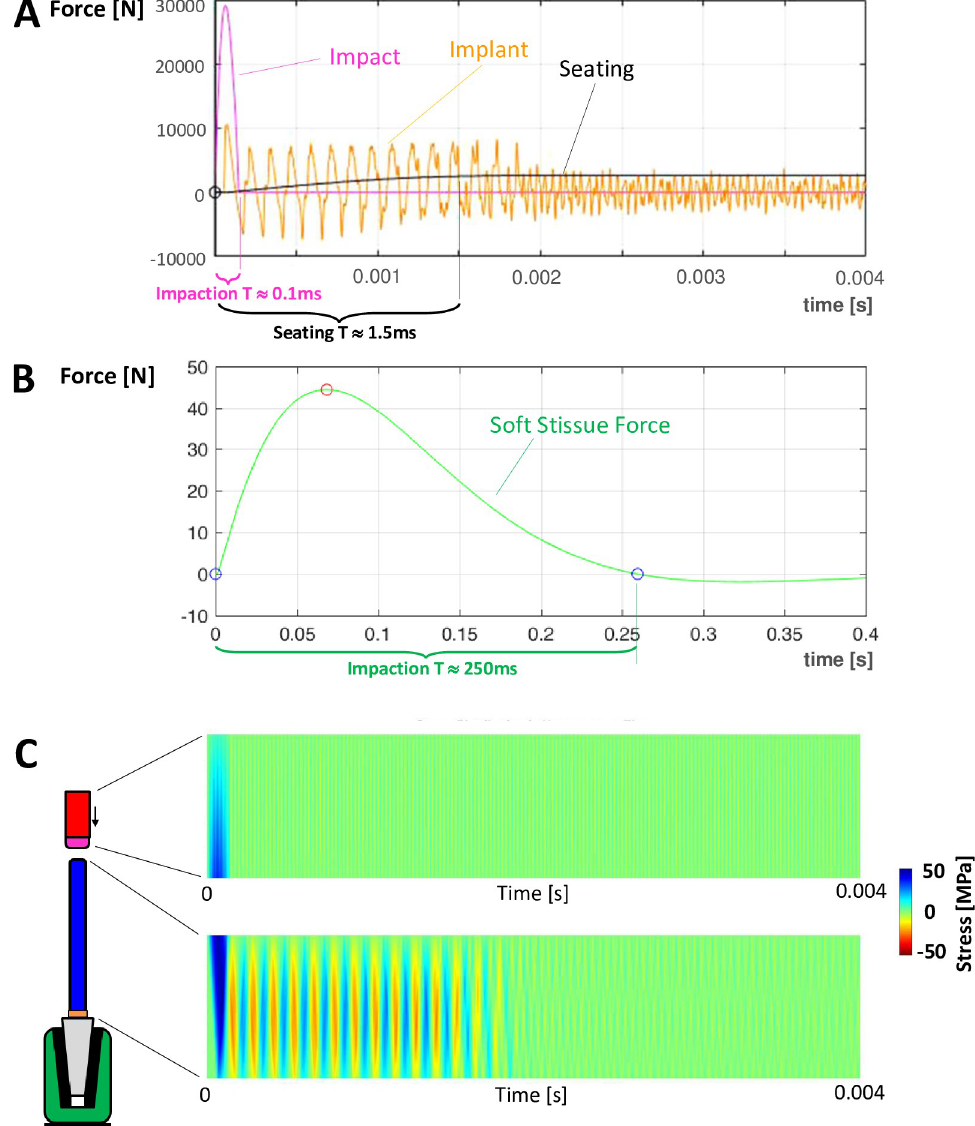
Fig 3. Force outputs are shown over time for the nominal variable magnitudes. Positive forces are compressive, negative tensile. A : Contact force between hammer tip and introducer (magenta, period 0.1ms), force between introducer and implant (orange), seating force of implant in bone (black, period 1.5ms). A period of 4ms is shown. B : Soft tissue forces (green). The compression period is 250ms. Note that the period shown is 0.4s (100 times greater than the graph above). C: Stress distributions along the lengths (vertical) of the hammer (above) and introducer (below) over the same 0.004s time period as for plot A (horizontal). The load transfer can be observed dynamically in S1